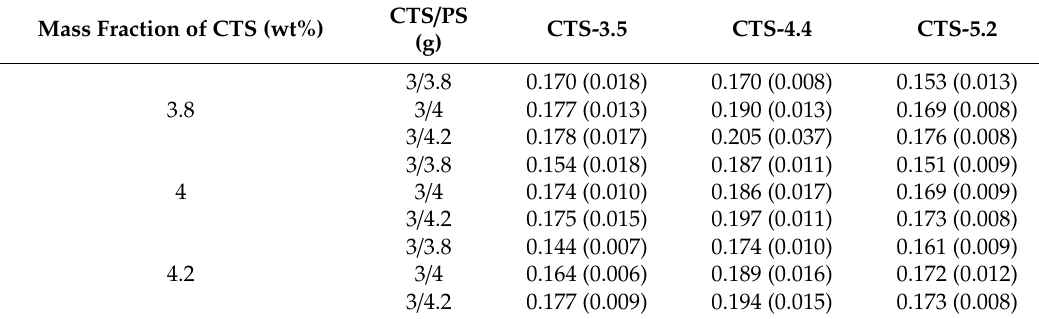
Figure 4. The density of foams with CTS solution for 4.2 wt%. Table 4. The density values of CTS–PS foams.